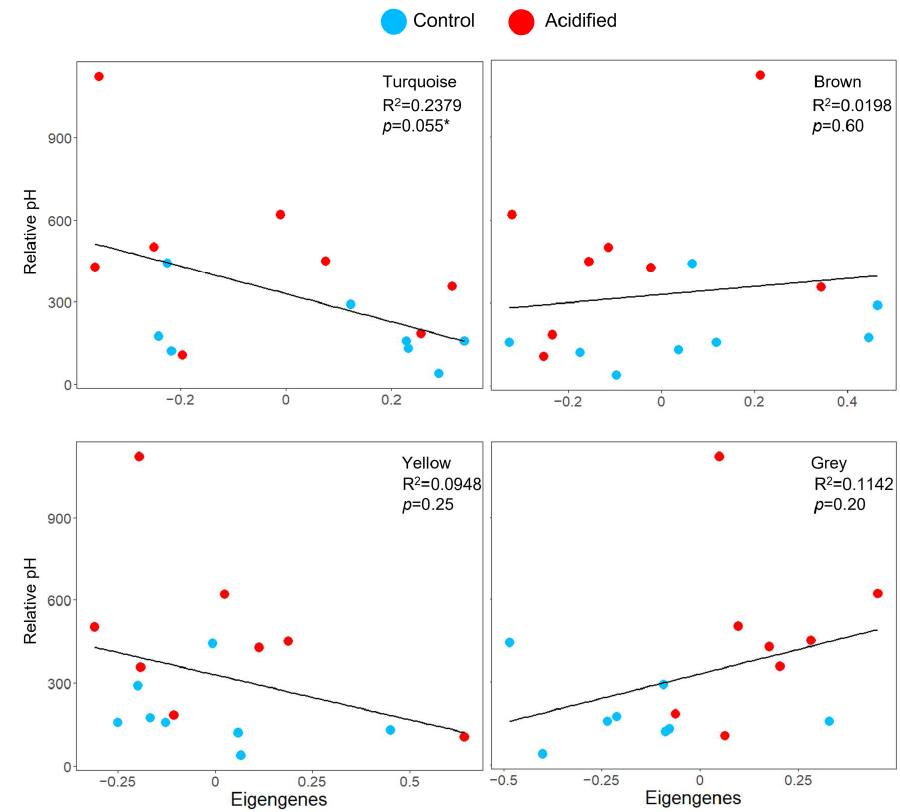
Figure 4. Co-expression responses to OA. Top four modules associated with clam EPF (colors are randomly assigned by the WGCNA package and have no meaning). Scatterplots of the pH i (y-axis, represented as relative fluorescence units measured by the flow cytometer) of EPF hemocytes by eigengene expression (x-axis). R 2 and p -values for the linear regressions are provided. * denotes sig- nificance.